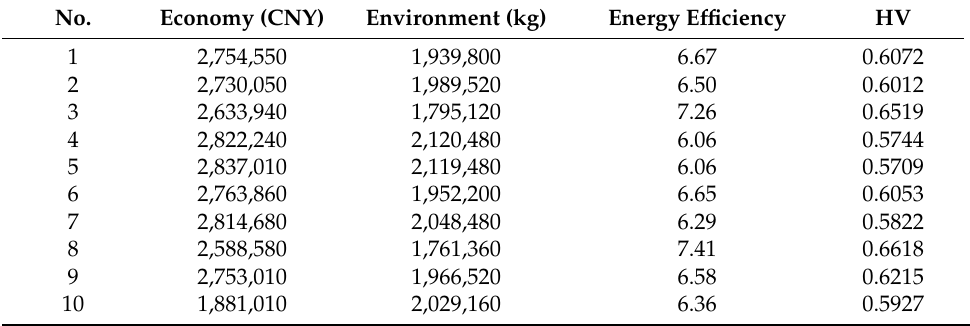
Table 3. Pareto optimal solutions of the NSGA-II algorithm for different